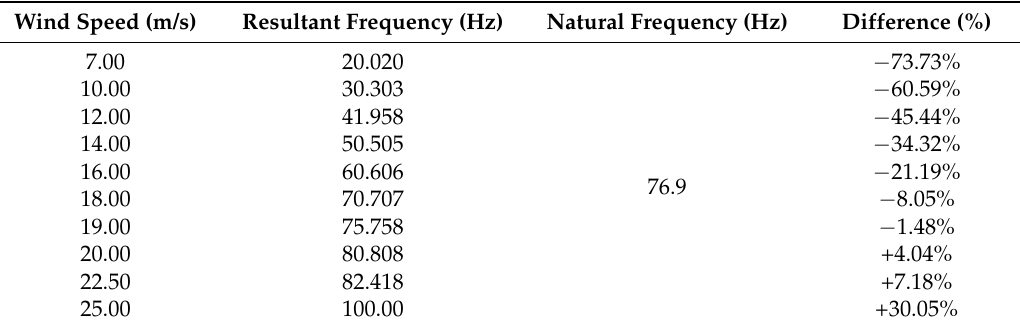
Table 4. Difference between vibrational and natural